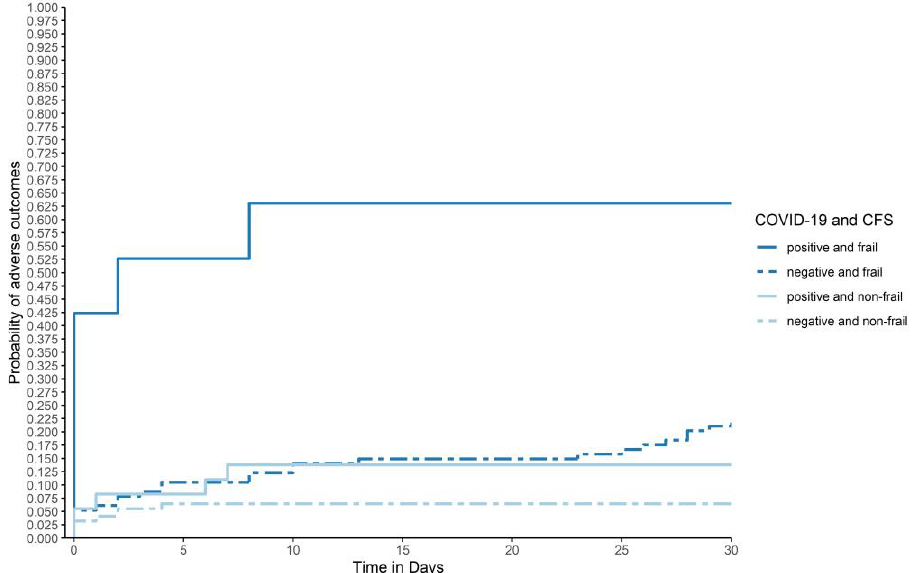
Figure 3. Adverse outcomes by frailty and swab status: Graphical description of adverse outcomes (composite outcome of 30-day-mortality or 30-day-ICU-admission), based on a Cox regression with combined groups of COVID-19 and CFS-status as strata, adjusted for age and gender, within the first 30 days after ED-admission for all patients in each subgroup (COVID-19-positive and frail, COVID-19-negative and frail, COVID-19-positive and non-frail, and COVID-19-negative and non-frail; n = 372). Frailty-levels were collapsed to “frail” (CFS 5–9) and “non-frail” (CFS1–4). ( p < 0.001, p -value based on logistic regression).